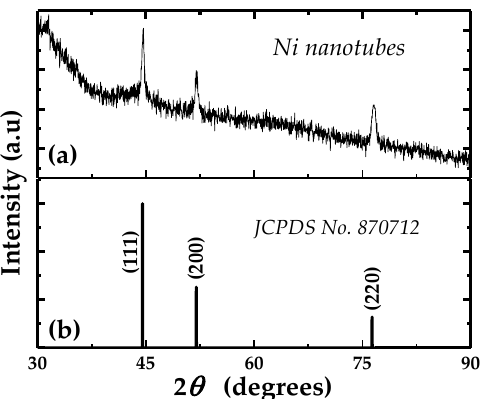
Figure 2. The X-ray diffraction pattern of Ni nanotubes embedded in polycarbonate (PC) template ( a ) with ( b ) JCPDS pattern of the standard Ni is shown for comparison with prepared samples.